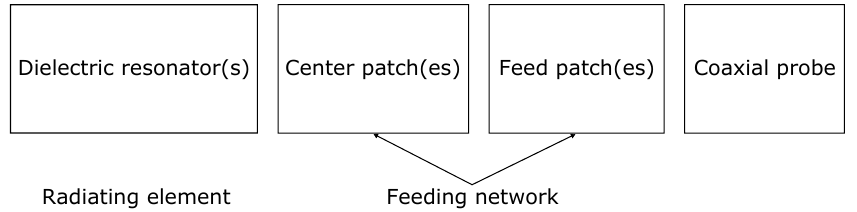
Figure 1. Block diagram of DRA array based on the proposed feeding method.